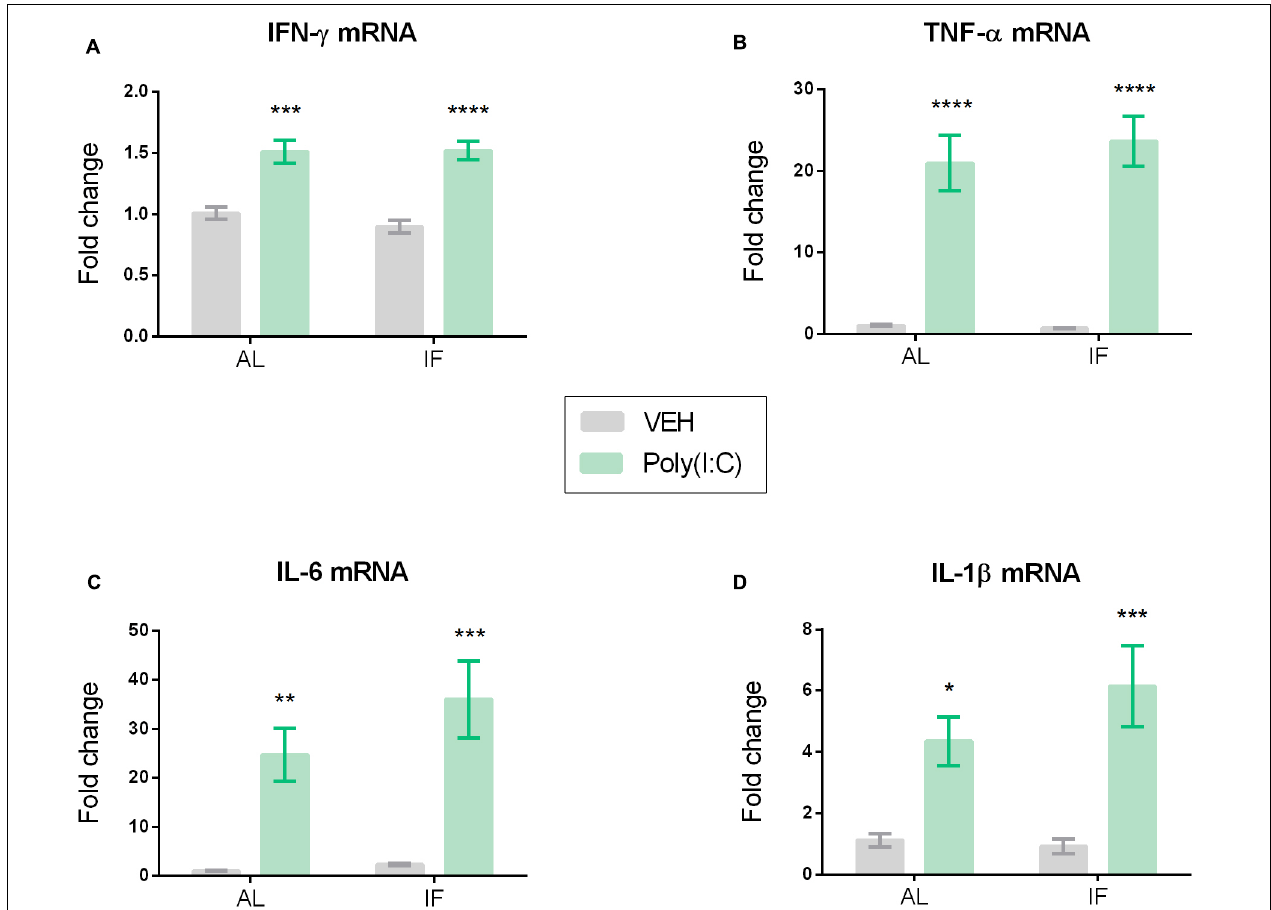
FIGURE 5 | Hypothalamic cytokine mRNA expression of (A) IFN- γ , (B) TNF- α , (C) IL-6, and (D) IL-1 β is elevated by peripheral Poly(I:C). Mice were kept on an ad libitum feeding regimen (AL) or deprived of food on every other day (IF) for 9 days. On day 10, mice were injected i.p. with vehicle (VEH) or Poly(I:C) (12 mg/kg) and 4 h later brains were extracted to evaluate hypothalamic cytokine mRNA expression. Values represent means ± SEM, (A–D) n = 7–8. Results of two-way ANOVA: F (1, 26) = 0.6824, p = 0.4163 for interaction of feeding regimen/Poly(I:C) in IFN- γ mRNA; F (1, 26) = 0.4720, p = 0.4982 for main effect of feeding on IFN- γ mRNA; F (1, 26) = 60.30, p ≤ 0.0001 for main effect of Poly(I:C) on IFN- γ mRNA; F (1, 25) = 0.3376, p = 0.5664 for interaction of feeding regimen/Poly(I:C) in TNF- α mRNA; F (1, 25) = 0.2003, p = 0.6583 for main effect of feeding on TNF- α mRNA; F (1, 25) = 70.09, p ≤ 0.0001 for main effect of Poly(I:C) on TNF- α mRNA; F (1, 26) = 0.9556, p = 0.3373 for interaction of feeding regimen/Poly(I:C) in IL-6 mRNA; F (1, 26) = 1.510, p = 0.2301 for main effect of feeding on IL-6 mRNA; F (1, 26) = 31.27, p ≤ 0.0001 for main effect of Poly(I:C) on IL-6 mRNA; F (1, 26) = 1.401, p = 0.2473 for interaction of feeding regimen/Poly(I:C) in IL-1 β mRNA; F (1, 26) = 0.8909, p = 0.3539 for main effect of feeding on IL-1 β mRNA; F (1, 26) = 25.39, p ≤ 0.0001 for main effect of Poly(I:C) on IL-1 β mRNA. Results of Sidak’s multiple comparison test: ∗ p ≤ 0.05, ∗∗ p ≤ 0.01, ∗∗∗ p ≤ 0.001, ∗∗∗∗ p ≤ 0.0001 compared to